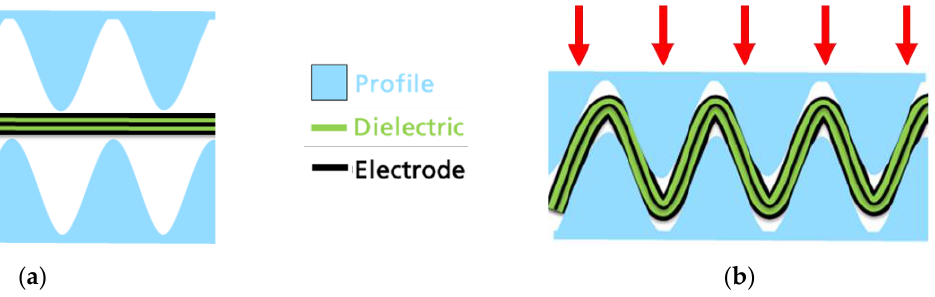
Figure 5. Scheme of a dielectric elastomer pressure sensor with two outer films with wave-shaped profiles and a flat dielectric elastomer strain sensor film with three electrode layers between the profiles in the unloaded state ( a ) and in the loaded state ( b ) [99].